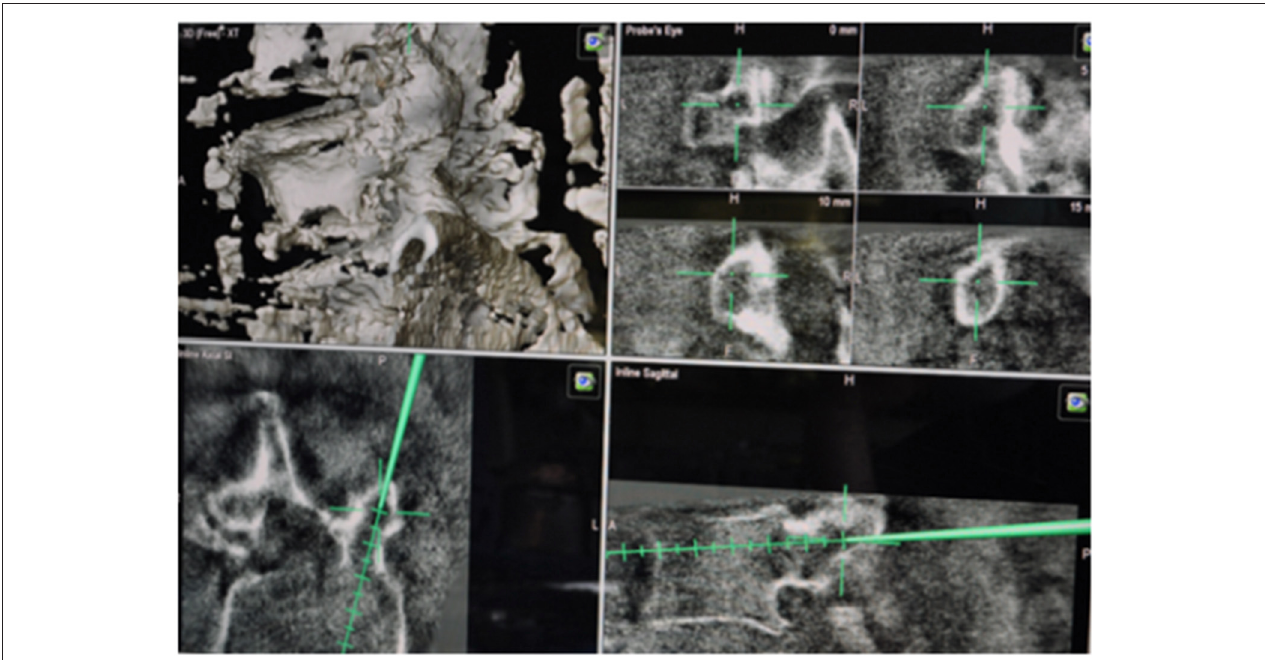
FIGURE 5 | Intraoperative navigation with BrainLab system. This shows the trajectories of screws transpedicular.